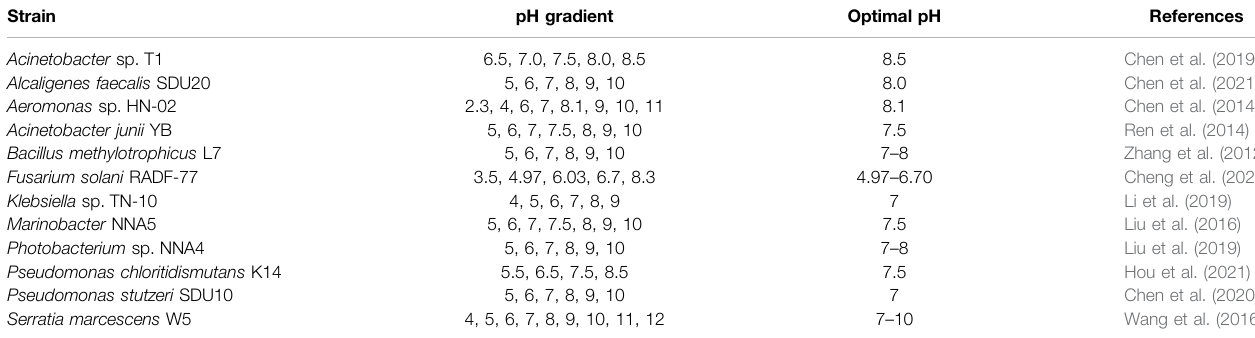
TABLE 6 | Ranges of pH for HNADs.